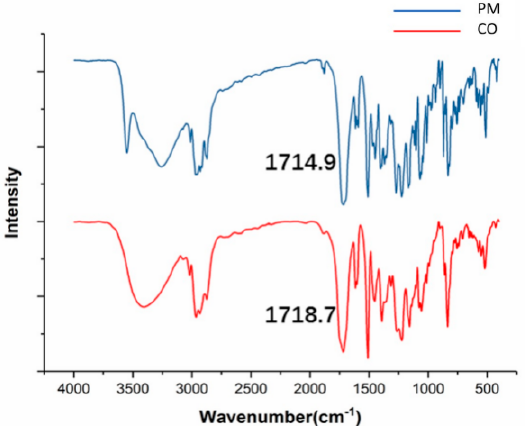
Figure 4. FT − IR spectra of the PM and CO samples of SIM-EZE.